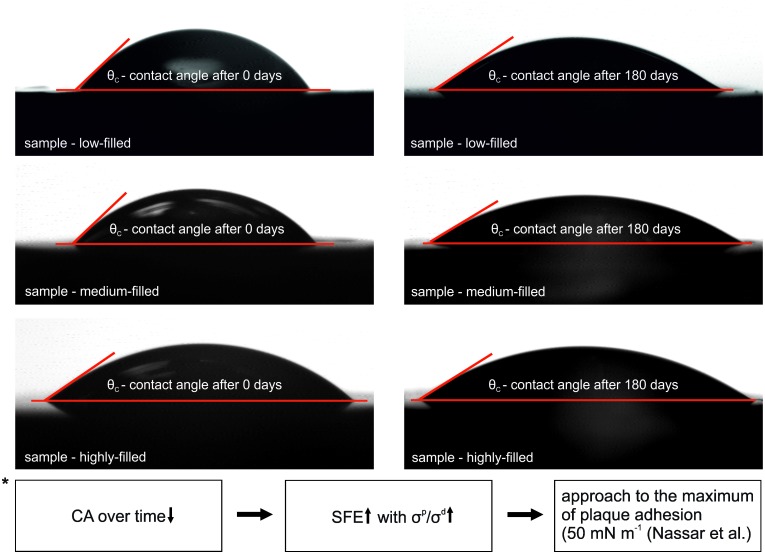
Contact angle (CA) measurement: Exemplary pictures of droplets of all composites for artificial saliva at 0 and 180 days; * estimation of bacterial adhesion according to the threshold value of 50 mN m-1 [26].